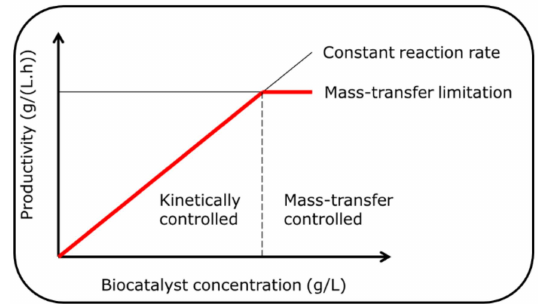
Figure 1. Productivity as a function of biocatalyst concentration. The red line indicates the observed productivity of the biocatalyst. The vertical dashed line indicates the boundary between the kinetically-controlled (left-hand side) and the mass–transfer controlled (right-hand side) of the plot. Target values for productivity are determined by the amount of product required in a given time, as well as the size of the reactors to be used. The size of the reactors is a clear indication of the capital costs (or else toll manufacturing costs) in a given case. Target productivities depend very much on the value of the product being produced (itself being linked to the mass of the product